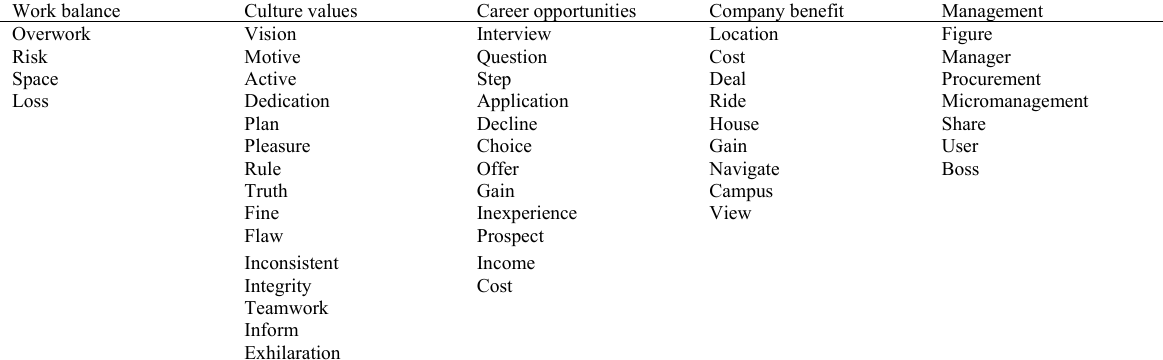
TABLE 4 T HE E XAMPLE OF M ANUALLY DEFINED ASPECTS AND THEIR FREQUENTLY OCCURRING KEYWORDS